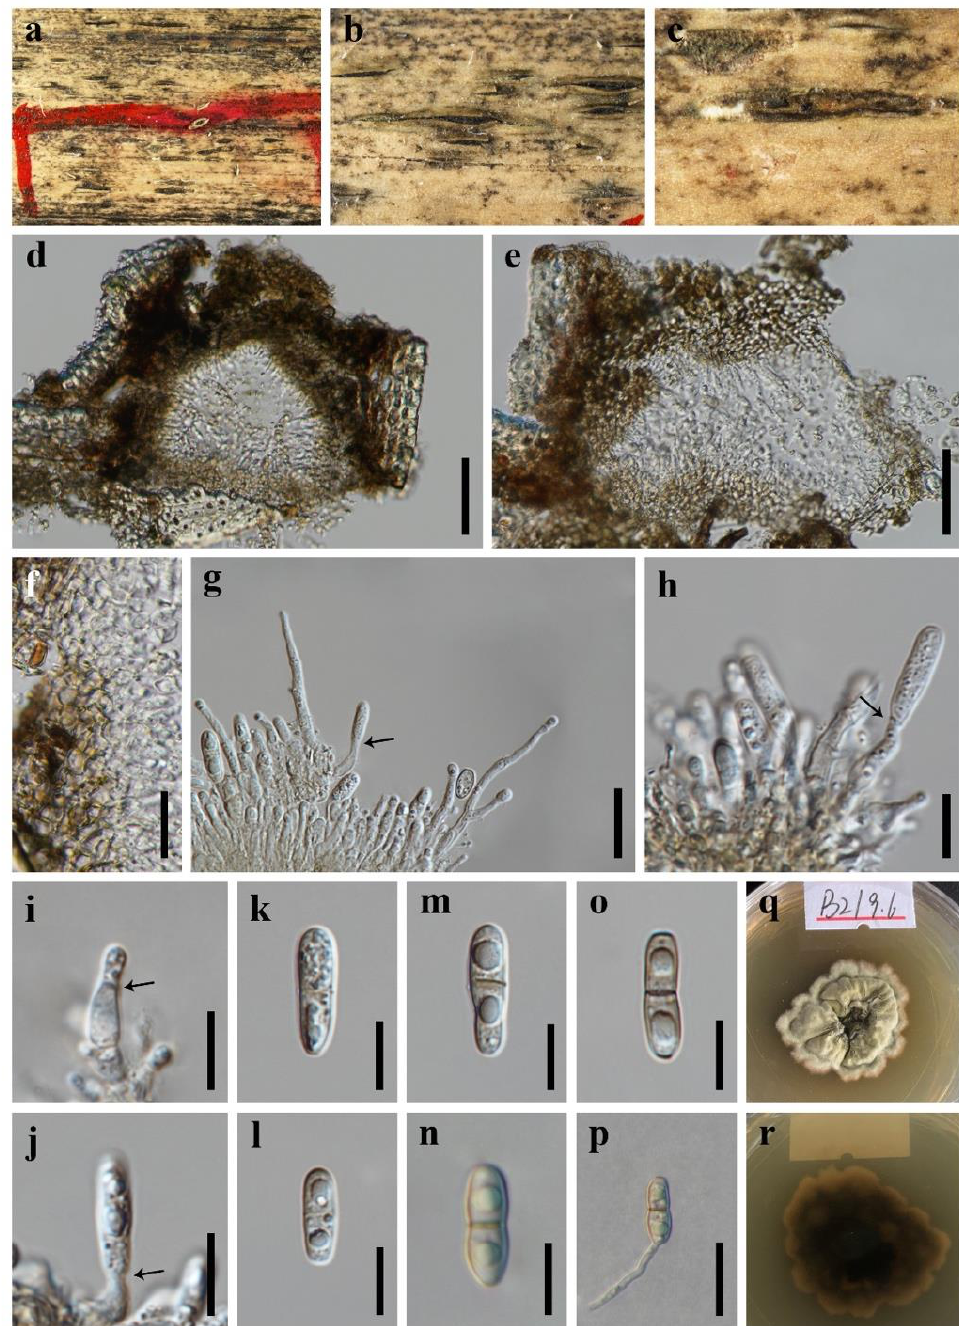
Figure 3. Bambusicola guttulata (HKAS 123091, holotype ) ( a – c ) Conidiomata on surface of dead bamboo culms. ( d , e ) Vertical section of conidioma. ( f ) Wall of conidioma. ( g – j ) Conidiogenous cells bearing conidia (the arrows indicated how the conidiogenous cells produce conidia). ( k – o ) Conidia. ( p ) Germinating conidia. ( q , r ) Colonies on PDA, above and below. Scale bars: ( d , e ) = 50 μm, ( f , g , p ) = 20 μm, ( h – o ) = 10 μm. Lophiostomataceae Sacc., Sylloge Fungorum 2: 672 (1883)